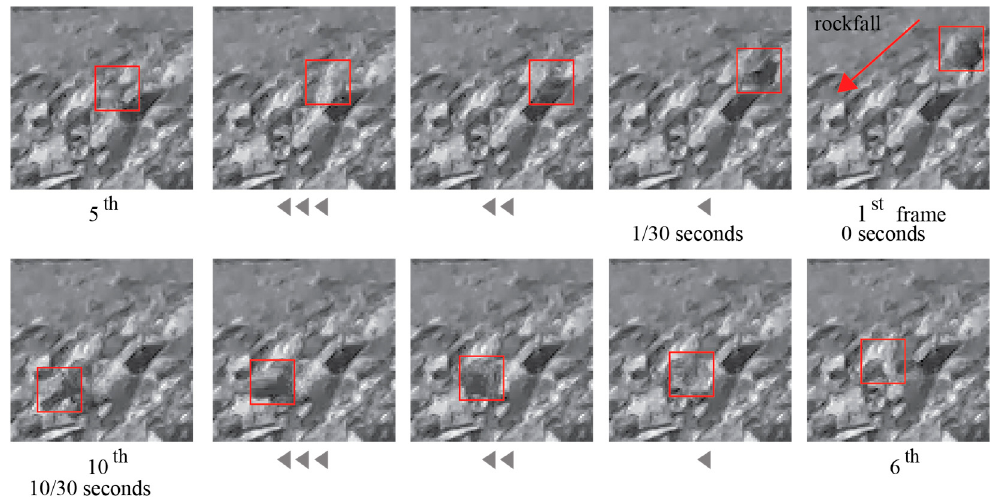
Figure 5. A clipped frame of the video record for test #4 and the rock block used for test #4. The red bounds highlight the detected rocks and fragments that arrived at the bottom with blur.